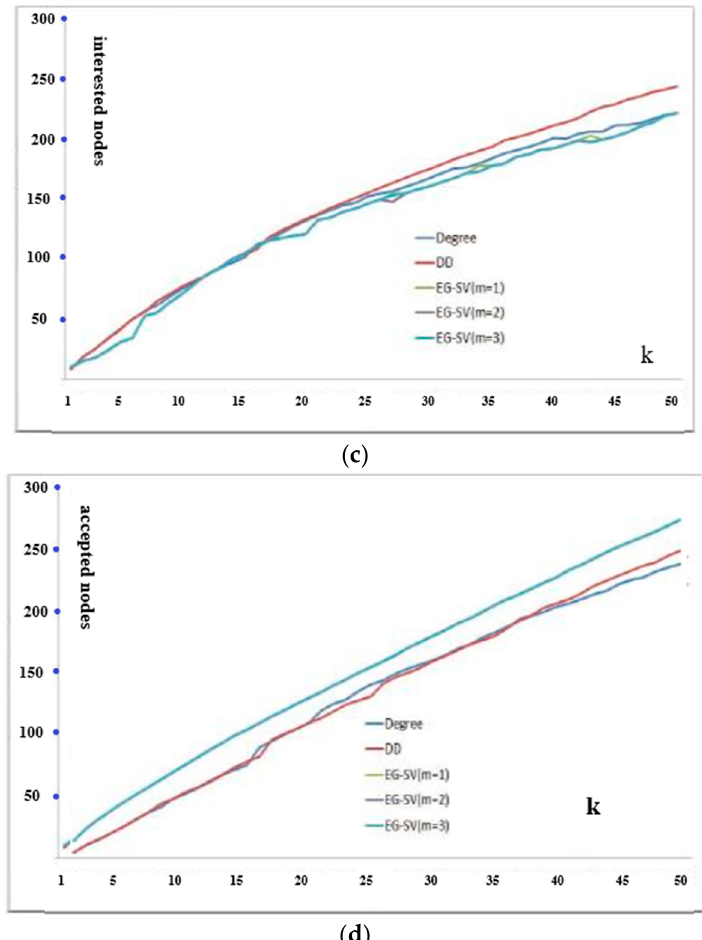
Figure 3. Interested and Accepted Nodes: ( a ) Interested Nodes P = 0.05 in CA-GrQc ( a , b ); ( b ) Accepted Nodes with P = 0.05 in CA-GrQc ( a , b ); ( c ) Interested Nodes with P = 0.1 in NetHEPT ( c , d ); ( d ) Accepted Nodes with P = 0.1 in NetHEPT ( c , d ).